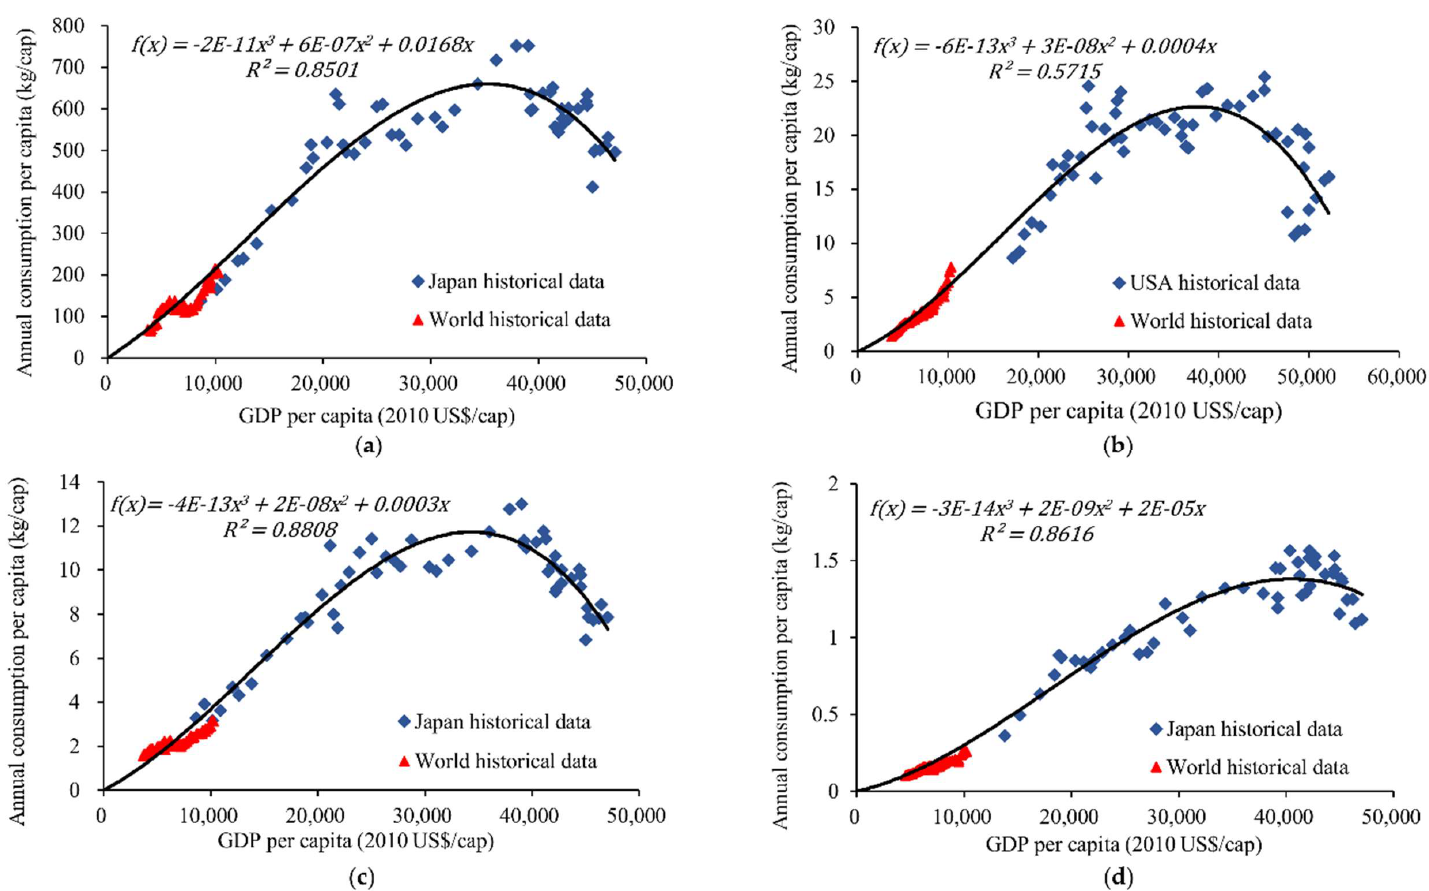
Figure A1. Approximation results of top-down model, where steel, copper and nickel were calculated using Japan data and aluminum was calculated using USA data to estimate future metal demand. ( a ) Steel ( b ) Aluminum ( c ) Copper ( d ) Nickel.